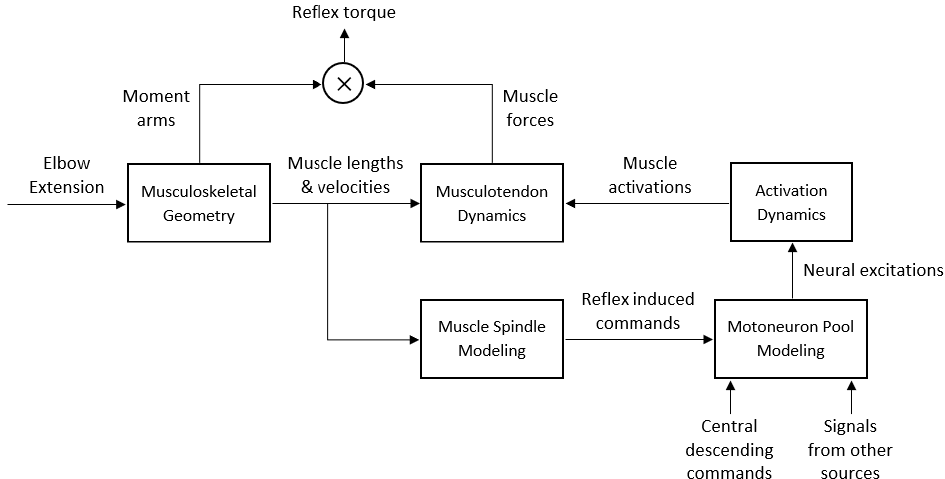
Figure 2. Example of system identification algorithm used by Shin et al. [69] for parameters characterizing the spastic reflexes, using muscle spindle, motor neuron pool, muscle activation dynamics, and musculoskeletal models to estimate the activate muscle torque generated by the spastic muscle during reflex.